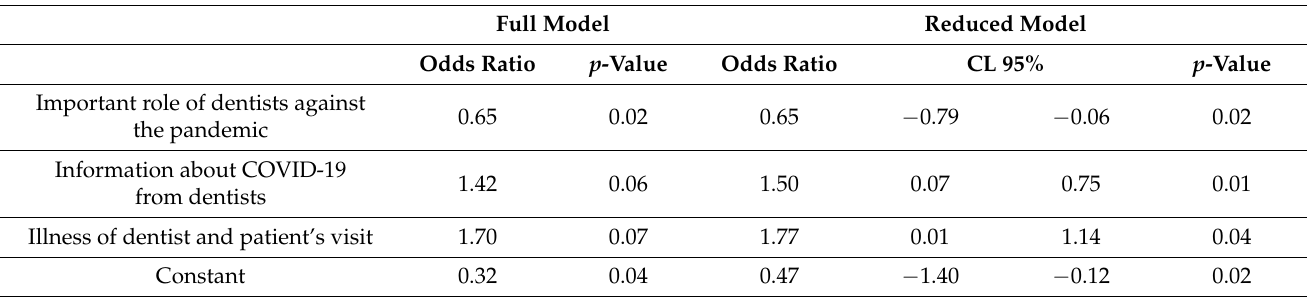
Table 3. Multiple logistic regression results with willingness to keep appointments as the depen- dent